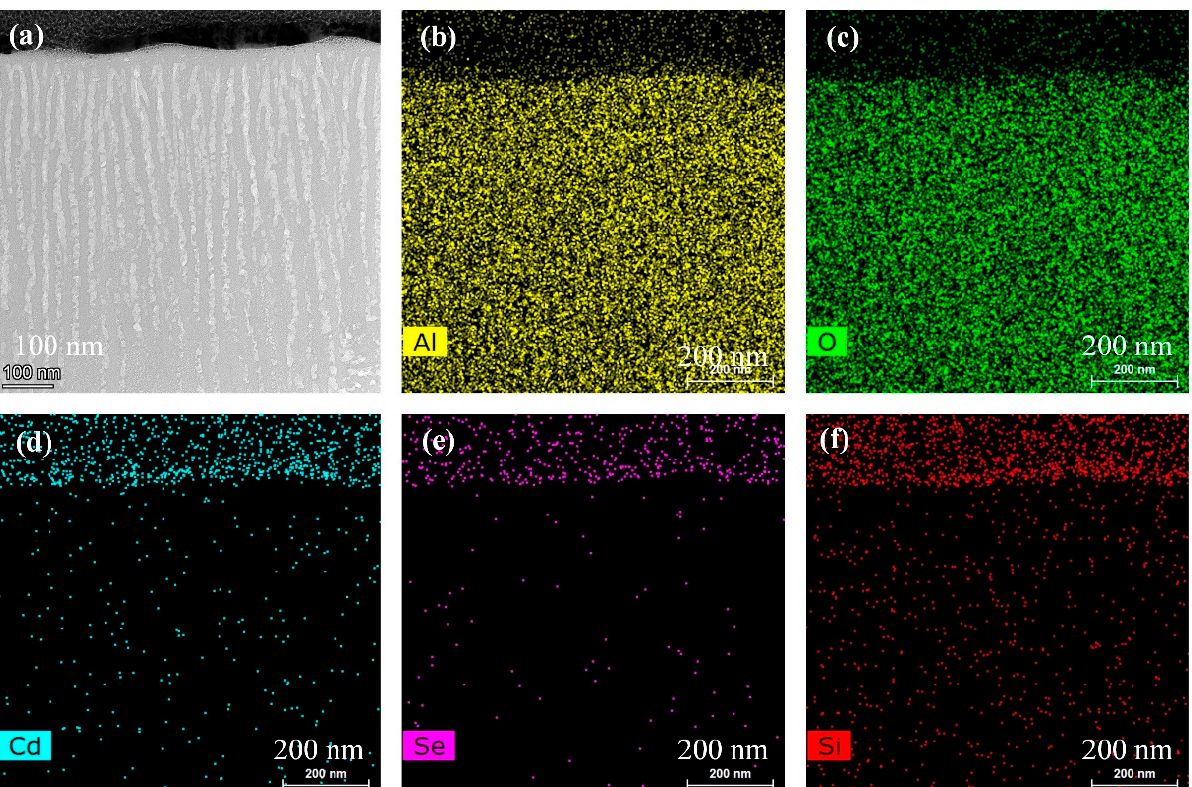
Figure 4. ( a ) Cross section of functional layers. Distribution of ( b ) aluminum, ( c ) oxygen, ( d ) cadmium, ( e ) selenium, and ( f ) silicon of functional layers.